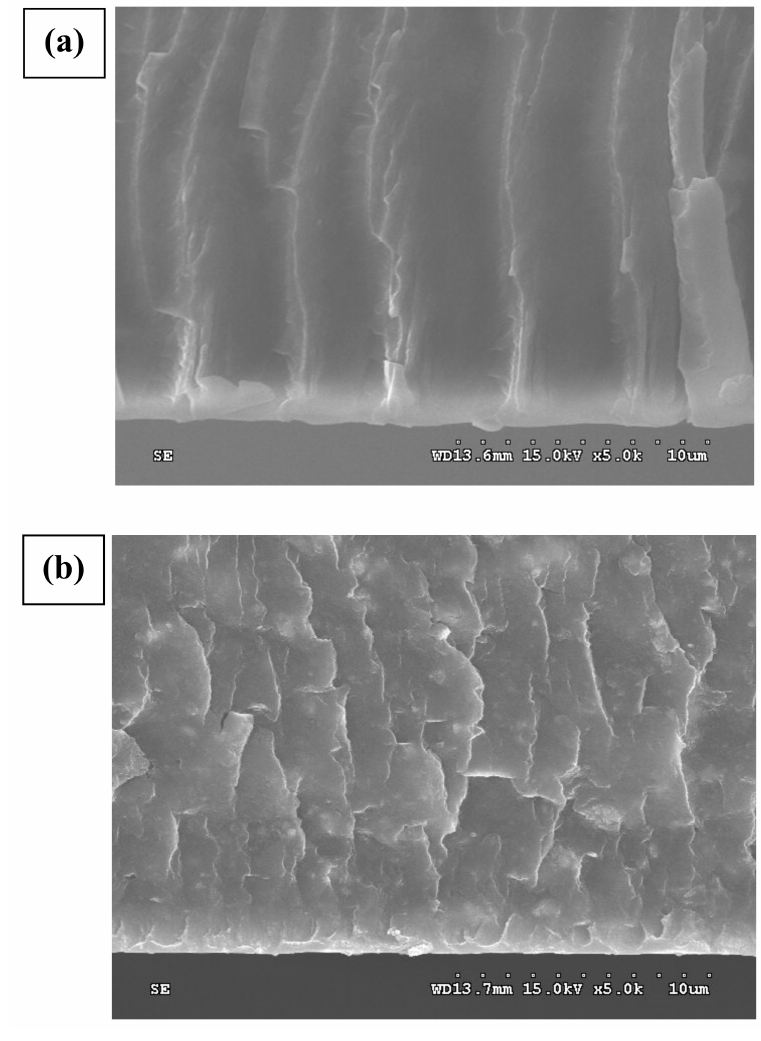
Figure 2. Cross-sectional SEM images of ( a ) Nafion 112, ( b ) NZT13 (Zr:Ti =